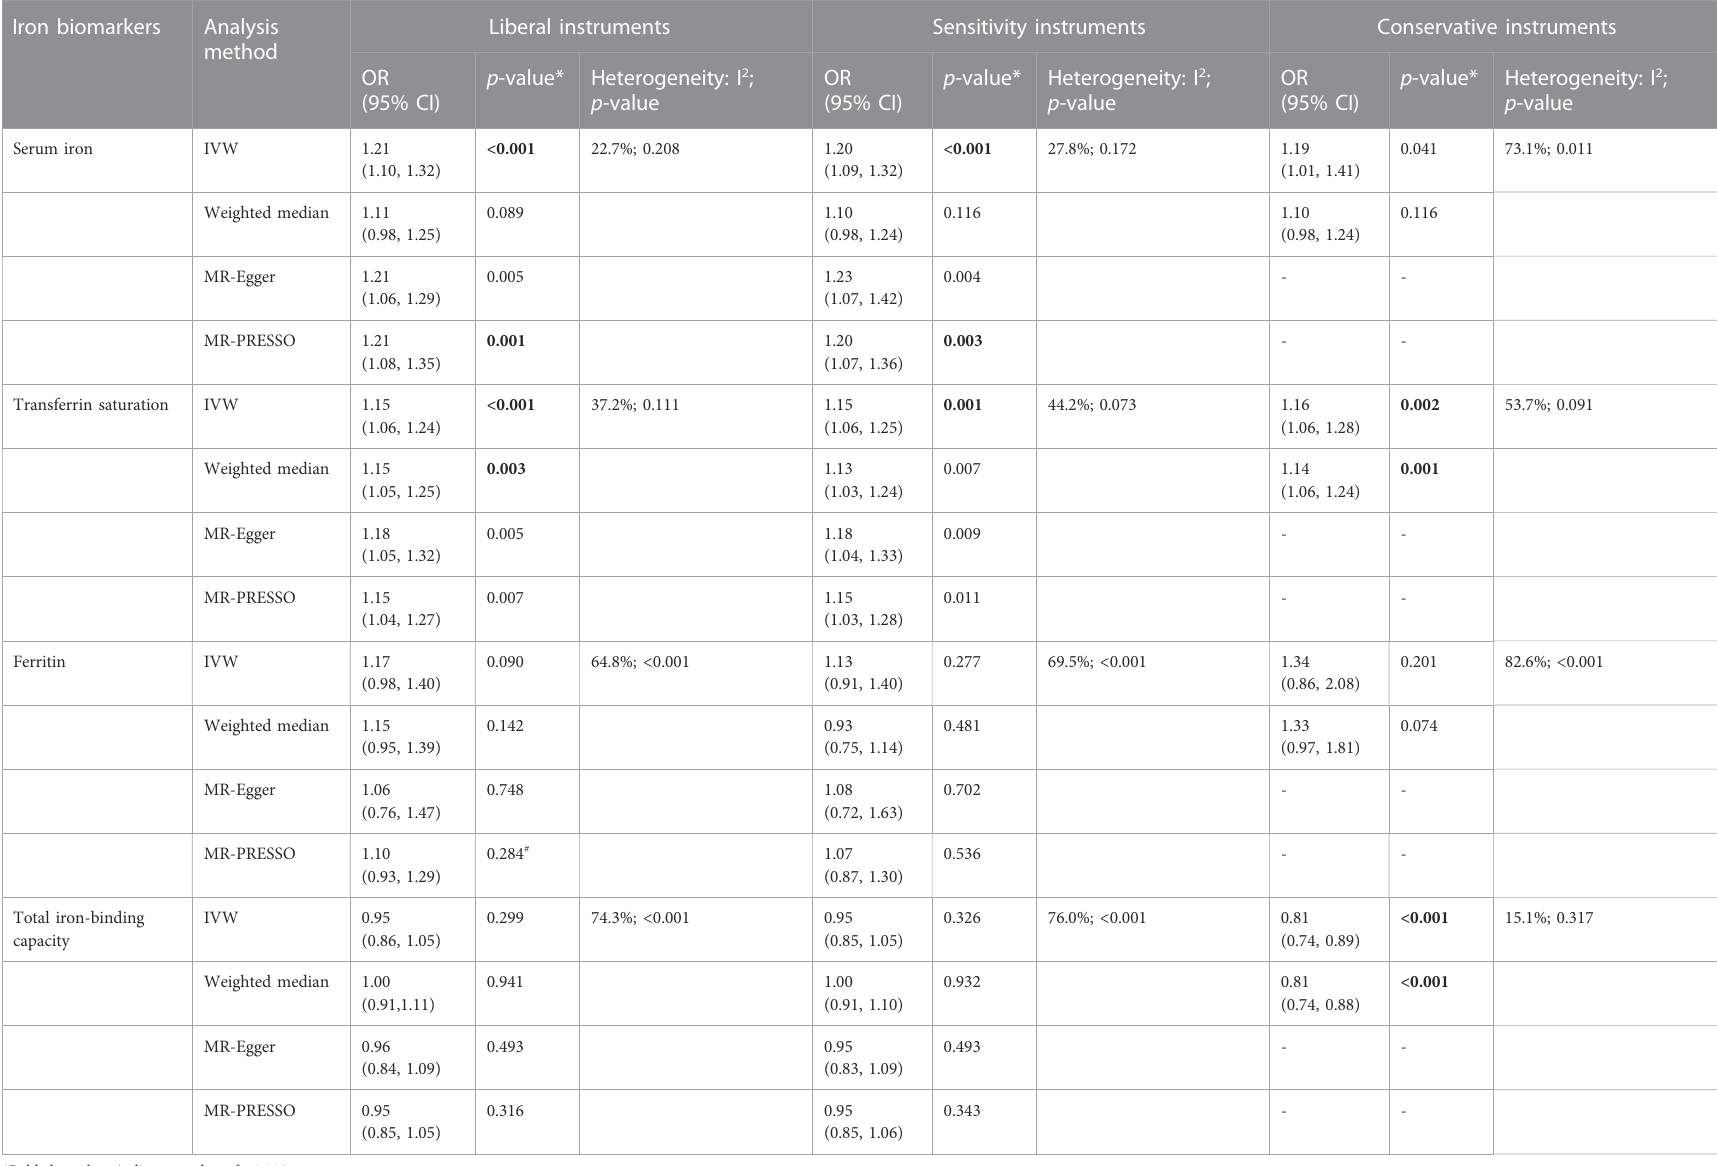
*Bolded p values indicate a value of < 0.003. #Presented with outlier-corrected value because the global test of the pleiotropy is signi fi cant ( p < 0.05). IVW, inverse variance weighted; MR-PRESSO, mendelian randomization pleiotropy residual sum and outlier; OR, odds ratio; CI, compatibility/con fi dence